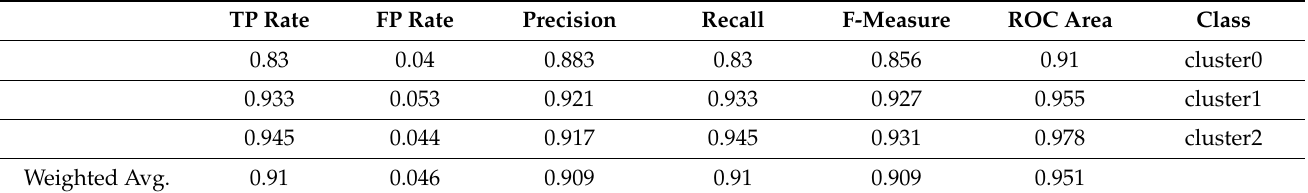
Table 9. Accuracy of the